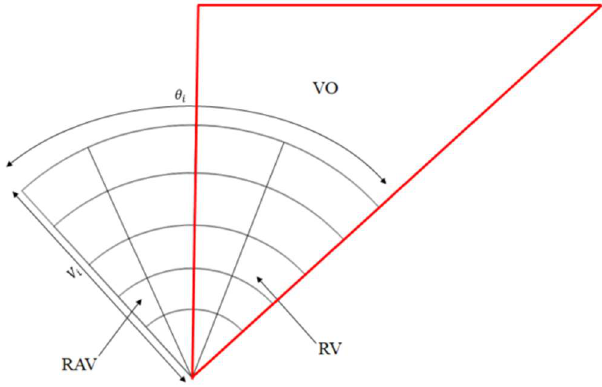
Figure 7. RV(Reachable Velocity)and RAV (Reachable Avoidance Velocity).